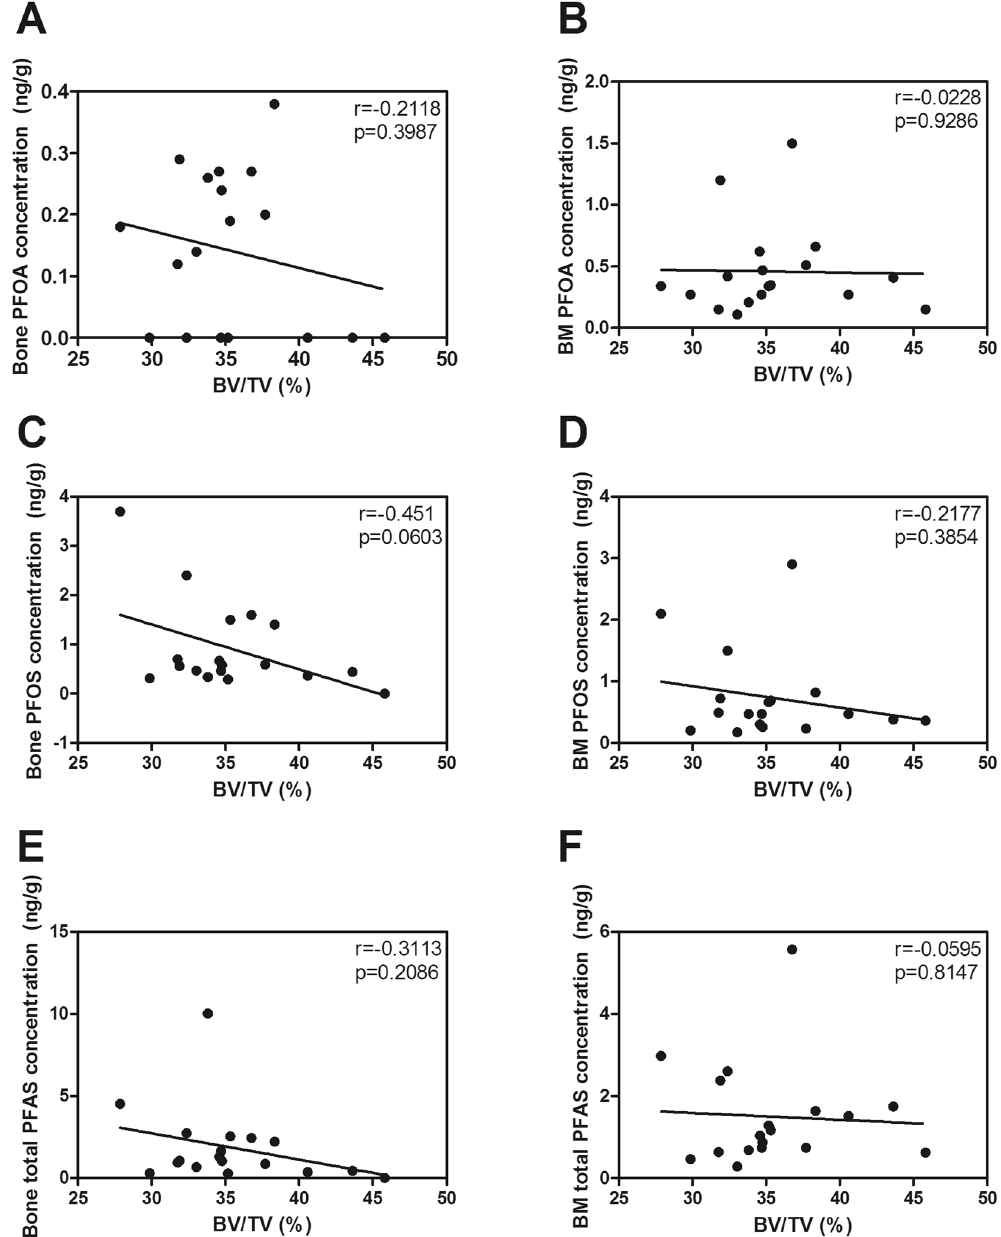
correlations with r and p